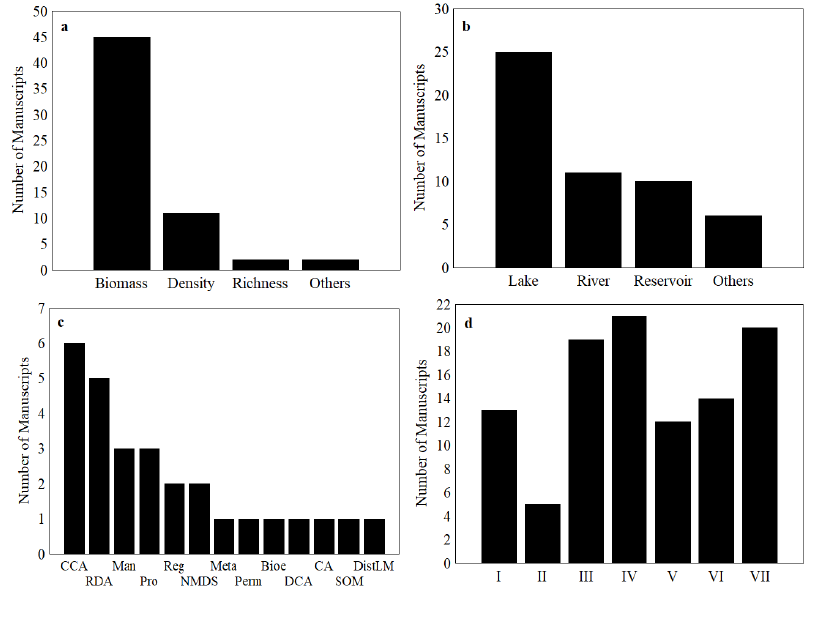
Figure 4. (a) Types of metrics used in the manuscripts to frame the phytoplankton taxa in MBFG; (b) Types of aquatic ecosystems in which the MBFG was applied; (c) Analysis methods used for comparisons between MBFG and other functional approaches (CCA - Canonical Correspondence Analysis; RDA - Redundancy Analysis; Man – Mantel Test; Pro – Procrust Test; Reg – Regression Analysis; NMDS - Non-Metric Multidimensional Scaling Analysis; Meta